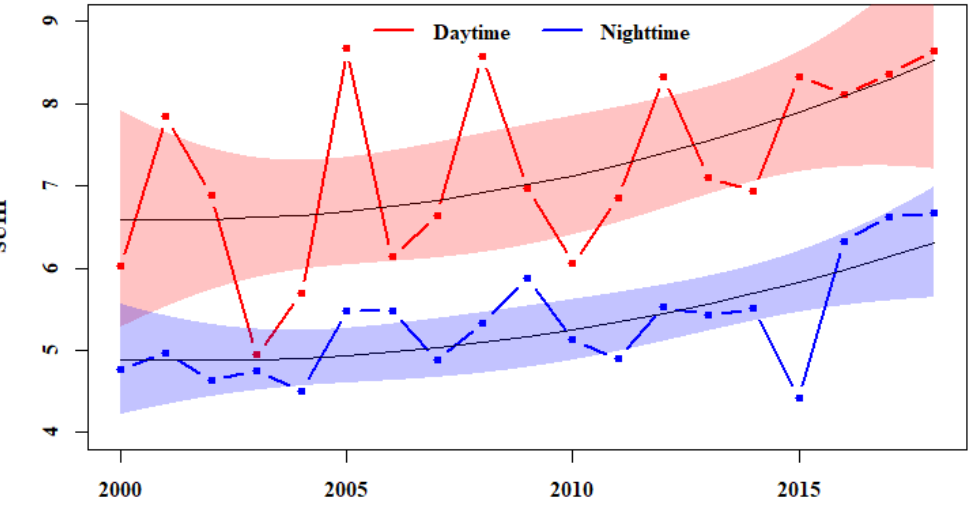
Figure 2. The mean SUHI values in urban area (UA) during the daytime and nighttime from 2000 to 2018. to NUA (new urban area), although the latter intensified more rapidly (Figure 3). From 2000 to 2014, areas with SUHI values higher than the “ sub- low” value accounted for less than 25% of the new urban area, while these SUHI levels accounted for more than 50% in the